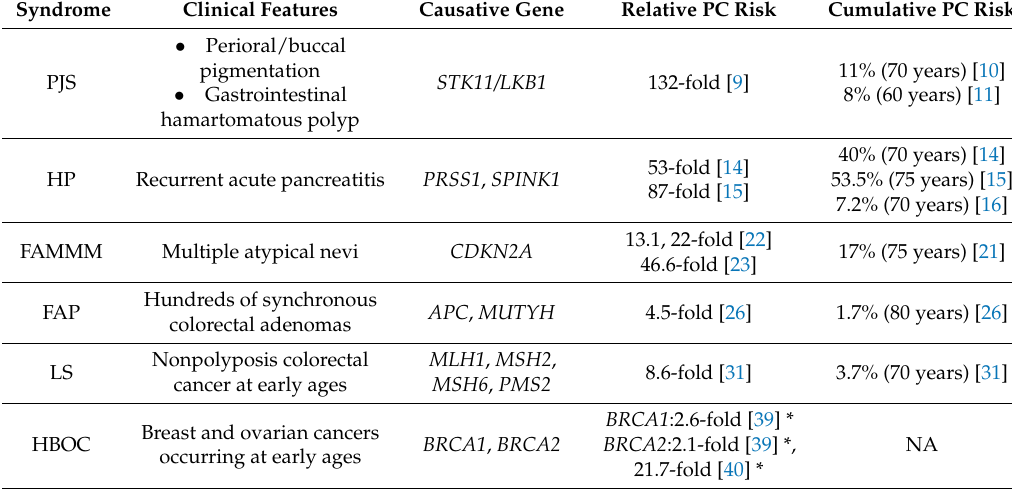
Table 1. Clinical and germline genomic features in hereditary